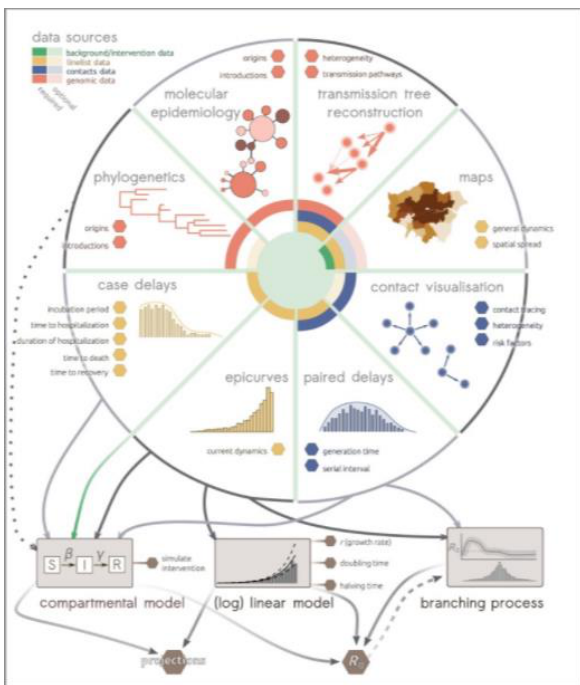
Figure 7 . Outbreak data analysis (Polonsky JA et al., 2019)